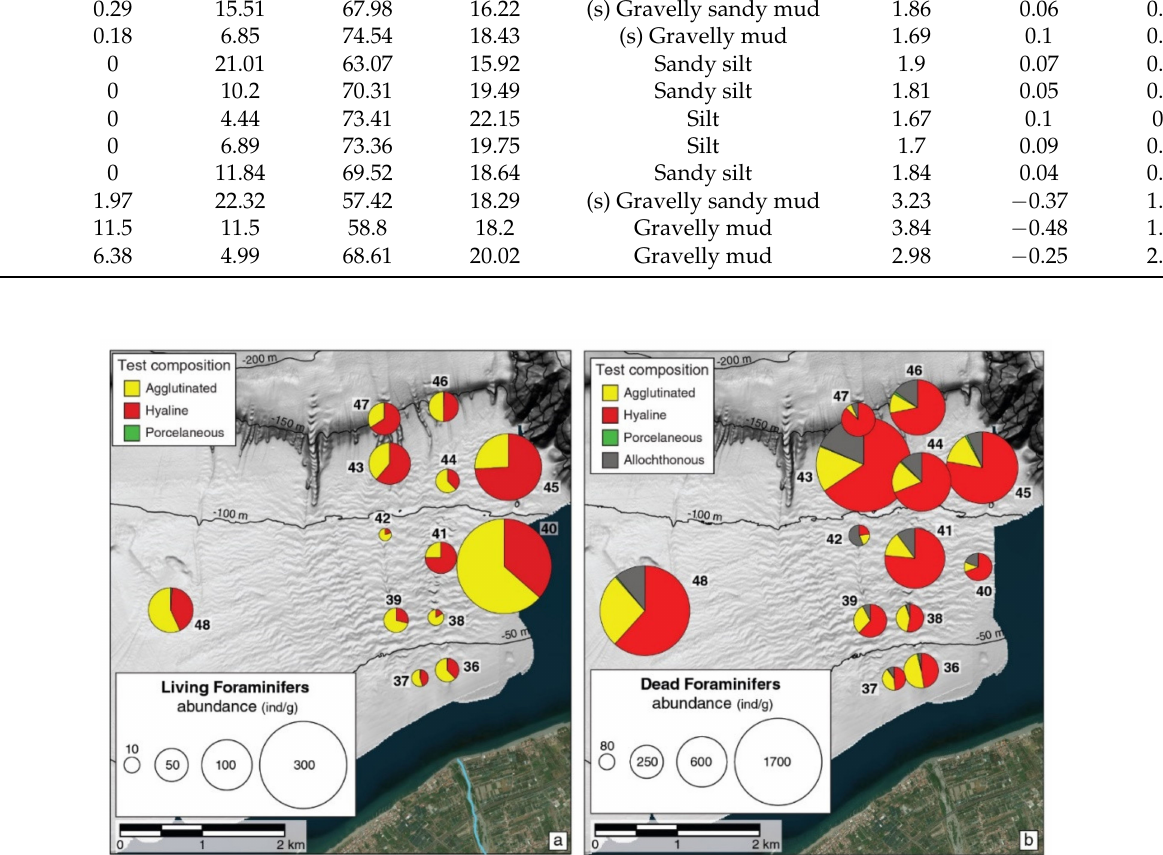
Figure 3. Test composition of living ( a ) and dead ( b ) foraminifera in the study area. Each pie chart is proportional to foraminiferal relative abundance. The size of the pie charts is based on average density values from the 0–5 cm sampled sediment